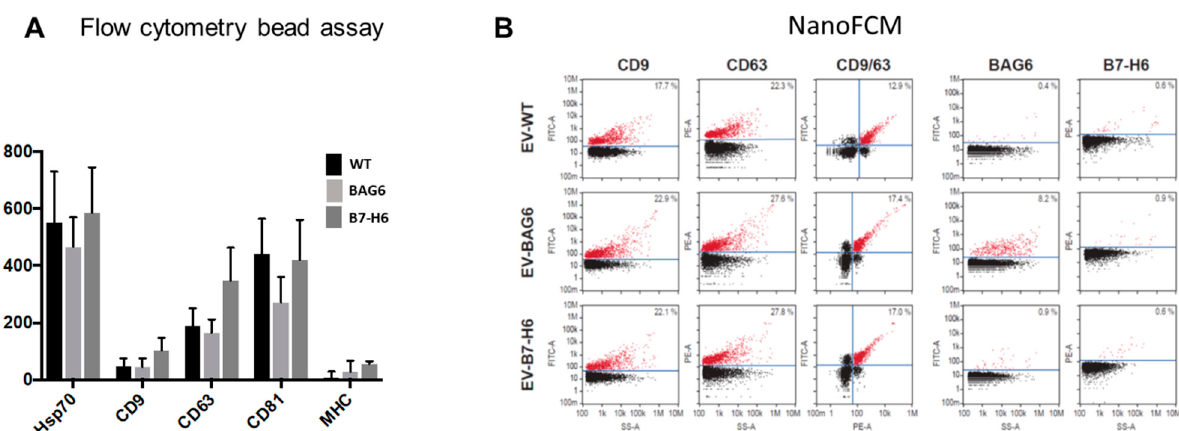
Figure 2. Detection of EV markers on the surface of EVs. ( A ) The tetraspanins CD9, CD63, and CD81, as well as Hsp70 and MHC-1, were detected on EVs using flow cytometry bead assay. Data are the mean of four to eight experiments ± SEM. ( B ) Representative plots of CD9, CD63, BAG6, and B7H6 expression on single EVs using FITC and PE-conjugated antibodies by nano flow cytometry (NanoFCM analysis ( n = 3)). Bivariate dot-plots of indicated fluorescence versus side scatter (SS-A) are shown. In addition, double positives for CD9/CD63 are depicted.